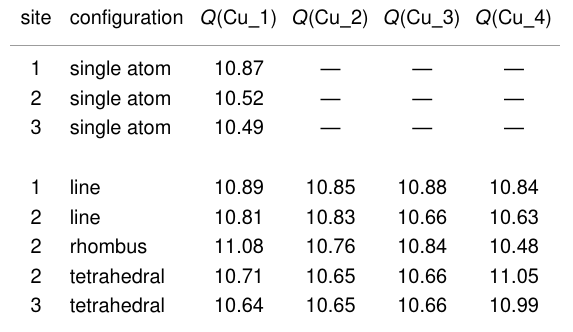
Table 8: Computed Bader charge ( Q ) at each Cu atom for all Cu 1 and Cu 4 adsorption configurations on the MoS 2 monolayer with an S vacancy. For the tetrahedral configuration, Cu_4 is at the apex, while the other three atoms are interacting with the monolayer. The rhombus structure rearranged and Cu_1 does not interact with the monolayer